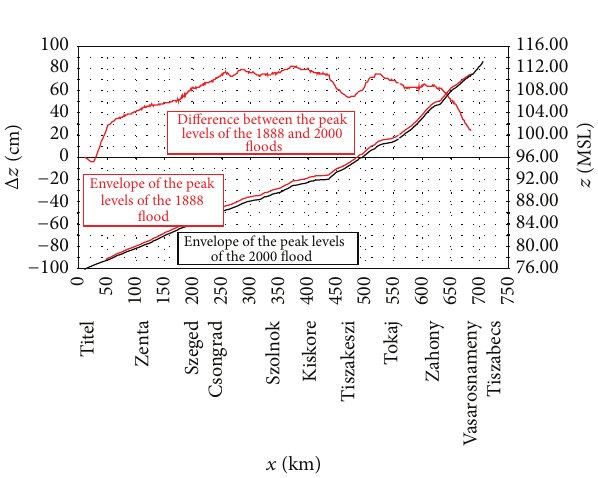
Figure 6: The expected maximum water levels of the 1888 flood calculated with the current condition of the watercourse, compared to the observed maximum water levels of the 2000